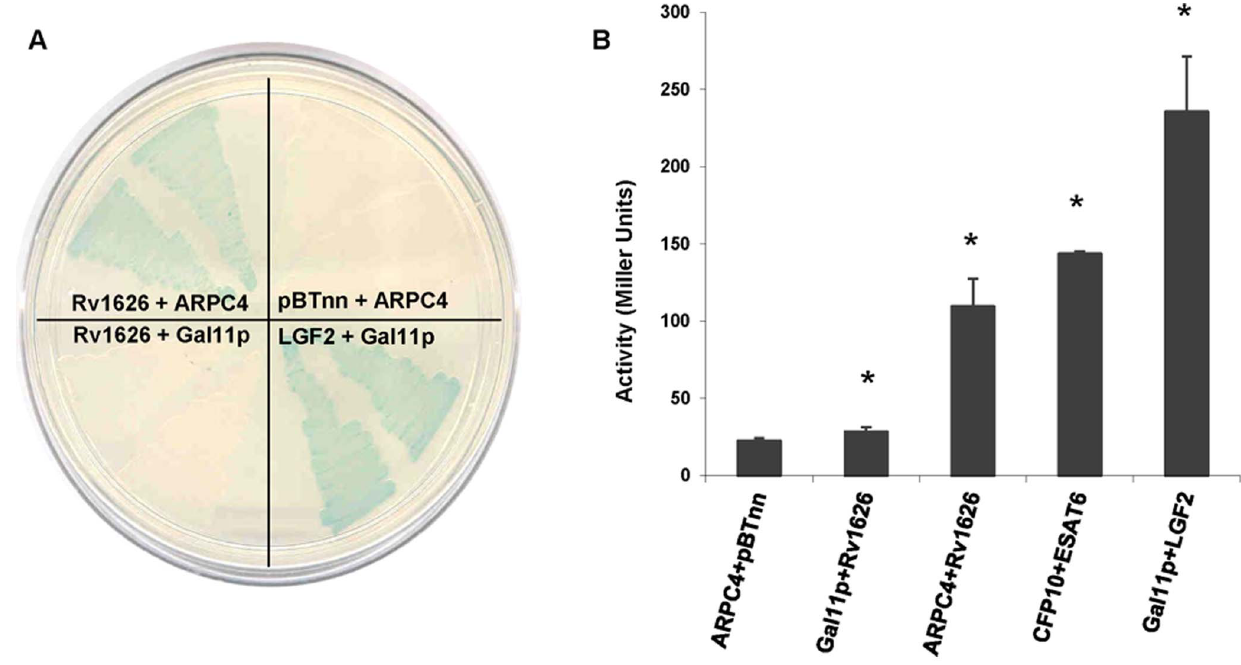
Figure 4. Rv1626-ARPC4 protein-protein interaction by bacterial two-hybrid. A. Bacterial two-hybrid plate showing Rv1626 and ARPC4 interaction where blue colored colonies show interaction between the bait and target proteins. BacterioMatch two-hybrid E. coli reporter strain was co-transformed with Rv1626-pBTnn + ARPC4-pTRGnn; pBTnn + ARPC4-pTRGnn (negative control); LGF2-pBT + Gal11p-pTRG (positive control); and Rv1626-pBTnn + Gal11p-pTRG (negative control) plasmids. Two individual colonies from each co-transformant were patched on X-gal indicator plate. B. Histogram of liquid b -galactosidase assay for quantitative estimation of interaction strength of Rv1626 and ARPC4 compared to that with positive and negative controls. Co-transformants ARPC4-pTRGnn + pBTnn and Gal11p-pTRG + Rv1626-pBTnn were taken as the negative controls; CFP10- pTRGnn + ESAT6-pBTnn and Gal11p-pTRG + LGF2-pBT were taken as positive controls; and these were used to compare the b -galactosidase activity of co-transformant ARPC4-pTRGnn + Rv1626-pBTnn. Enzyme activity is a direct indication of the strength of interaction of the bait and target proteins and, is expressed in terms of Miller Units. All interactions were found to be statistically significant by Student’s t-test (*, P , 0.05).